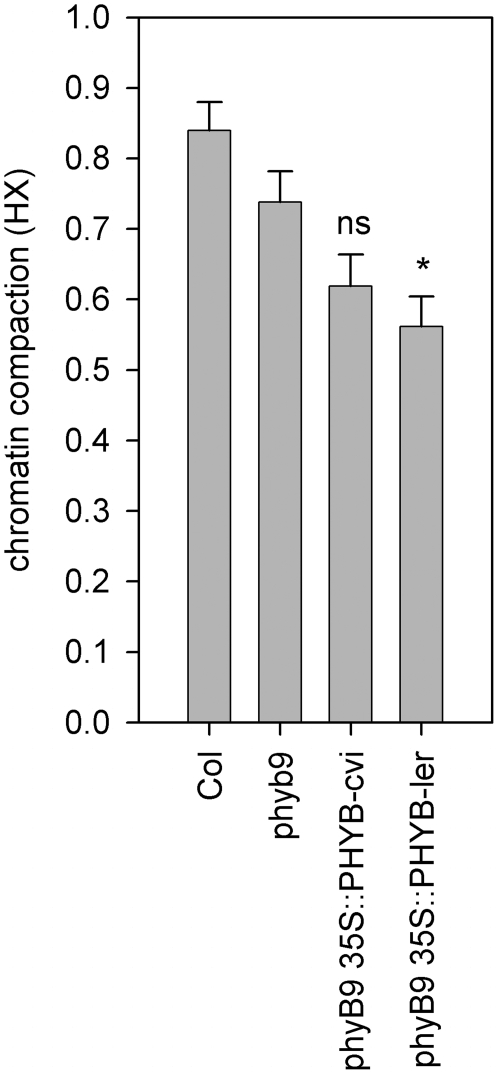
Ectopic expression of the Ler PHYB allele, but not the Cvi-0 allele, reduces chromatin compaction.Heterochromatin index of phyb9 mutant in the Col genetic background, complemented with gain-of-function PHYB alleles from Cvi-0 or Ler
[41] at 200 µmol m−2 s−1 in short-day photoperiod. Significance levels are compared to phyB9 values; * p<0.05; ns = non significant. Error bars represent SE in al cases.